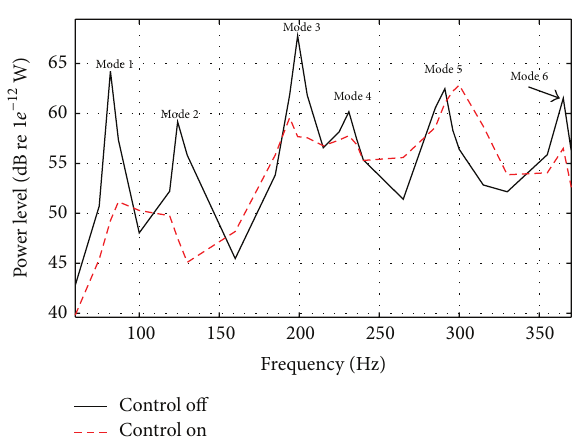
Figure 19: Experimental control of the clamped plate over the frequency range from 60 to 370 Hz.